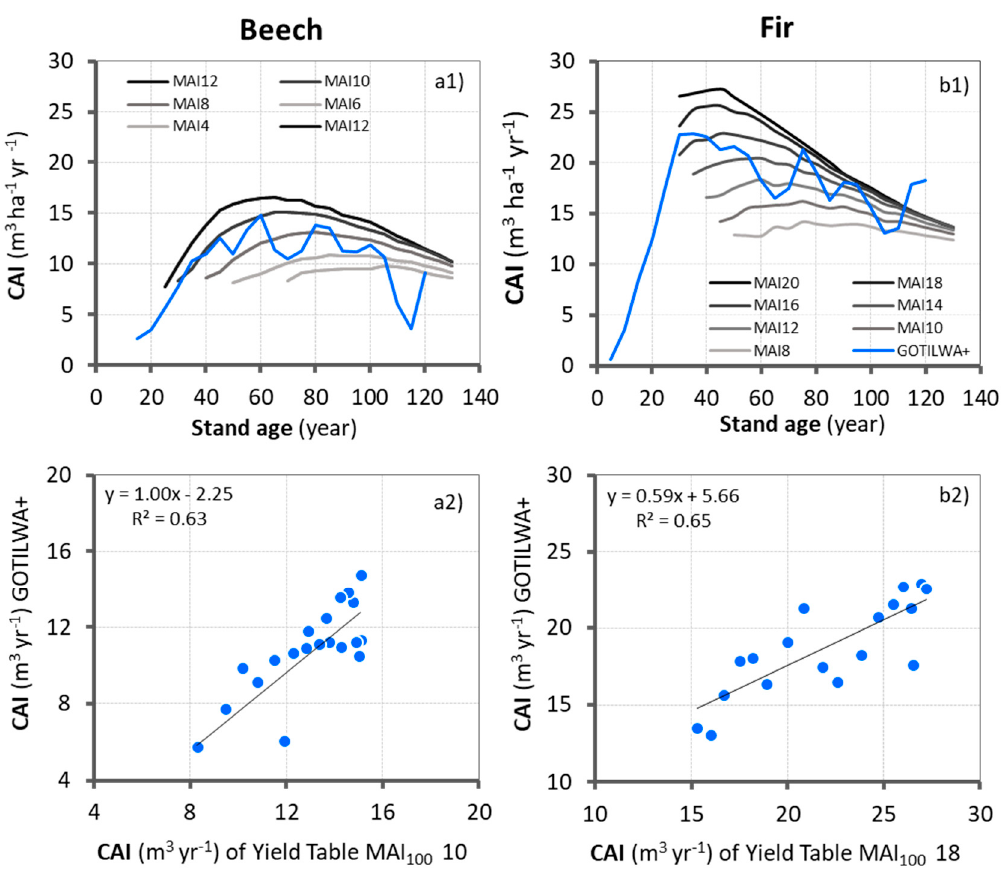
Figure 3. Current annual increment (CAI in m 3 ) values for ( a1 , a2 ) beech (left panel) and ( b1 , b2 ) fir (right panel) for five productivity classes from yield tables in Baden-Württemberg until stand age 130 (grey lines; data are from permanent experimental plots, FVA, 2001) and the business-as-usual scenario assuming no climate change with GOTILWA + . Productivity classes are expressed with mean annual increment (MAI in m 3 ha − 1 ) values at stand age 100 (grey lines)—for 5 and 8 productivity classes for beech and fir, respectively. Panel ( a2 , b2 ) show the relationship (significant at p < 0.05) of CAI of GOTILWA + with the CAI of the yield table for the productivity class MAI 100 10 for beech and MAI 100 18 for fir.